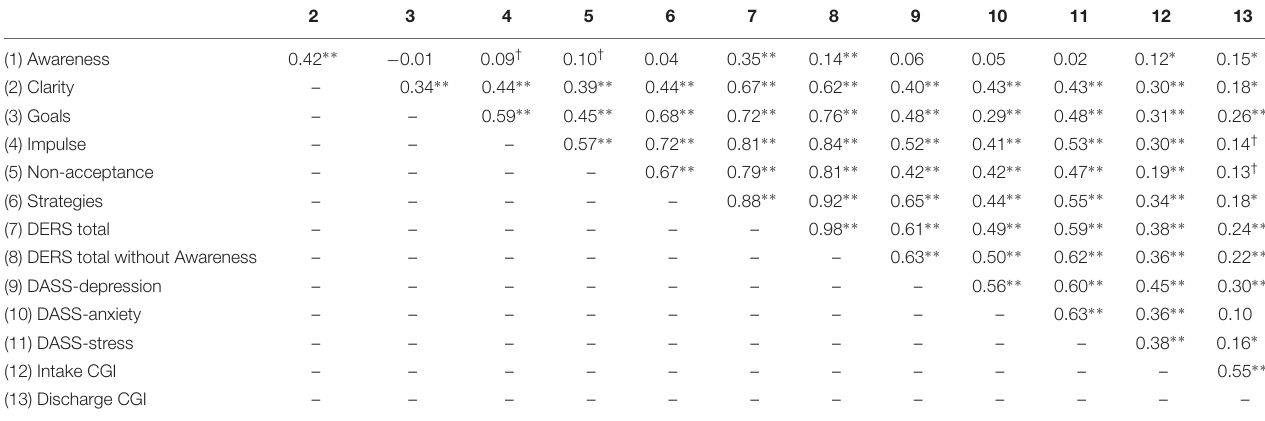
TABLE 2 | Bivariate